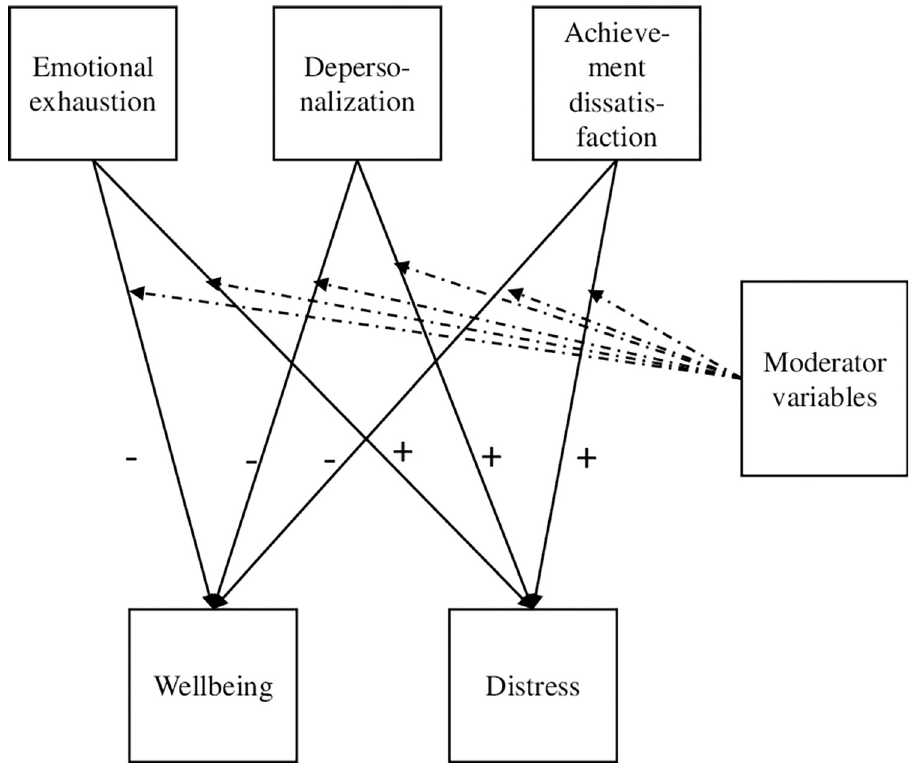
Fig 1. Conceptual model of the path analysis with moderator effects. Measurement error terms and covariances are not shown.